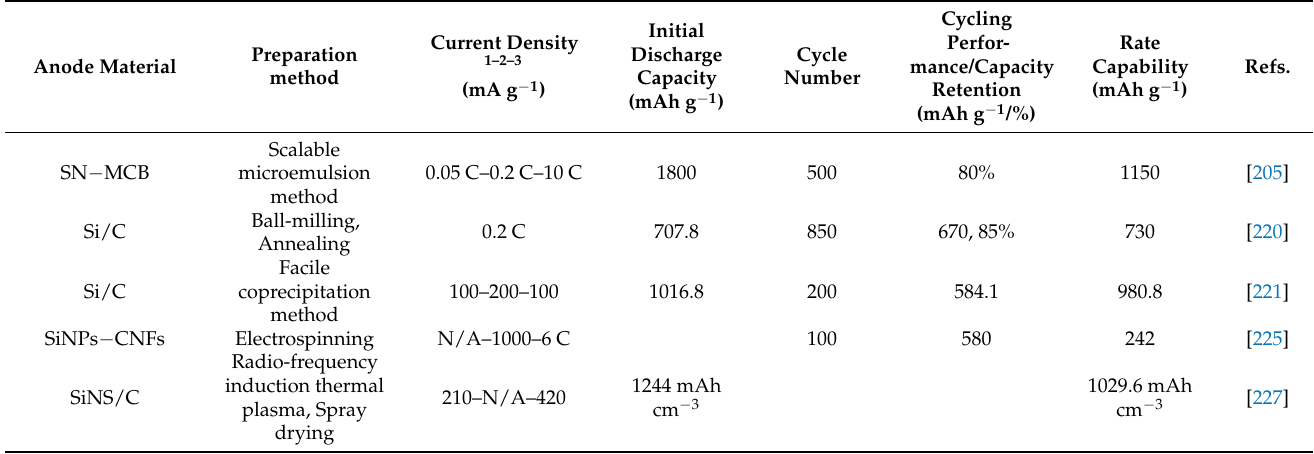
Table 4. Electrochemical performance of embedded silicon/carbon anodes for LIBs.